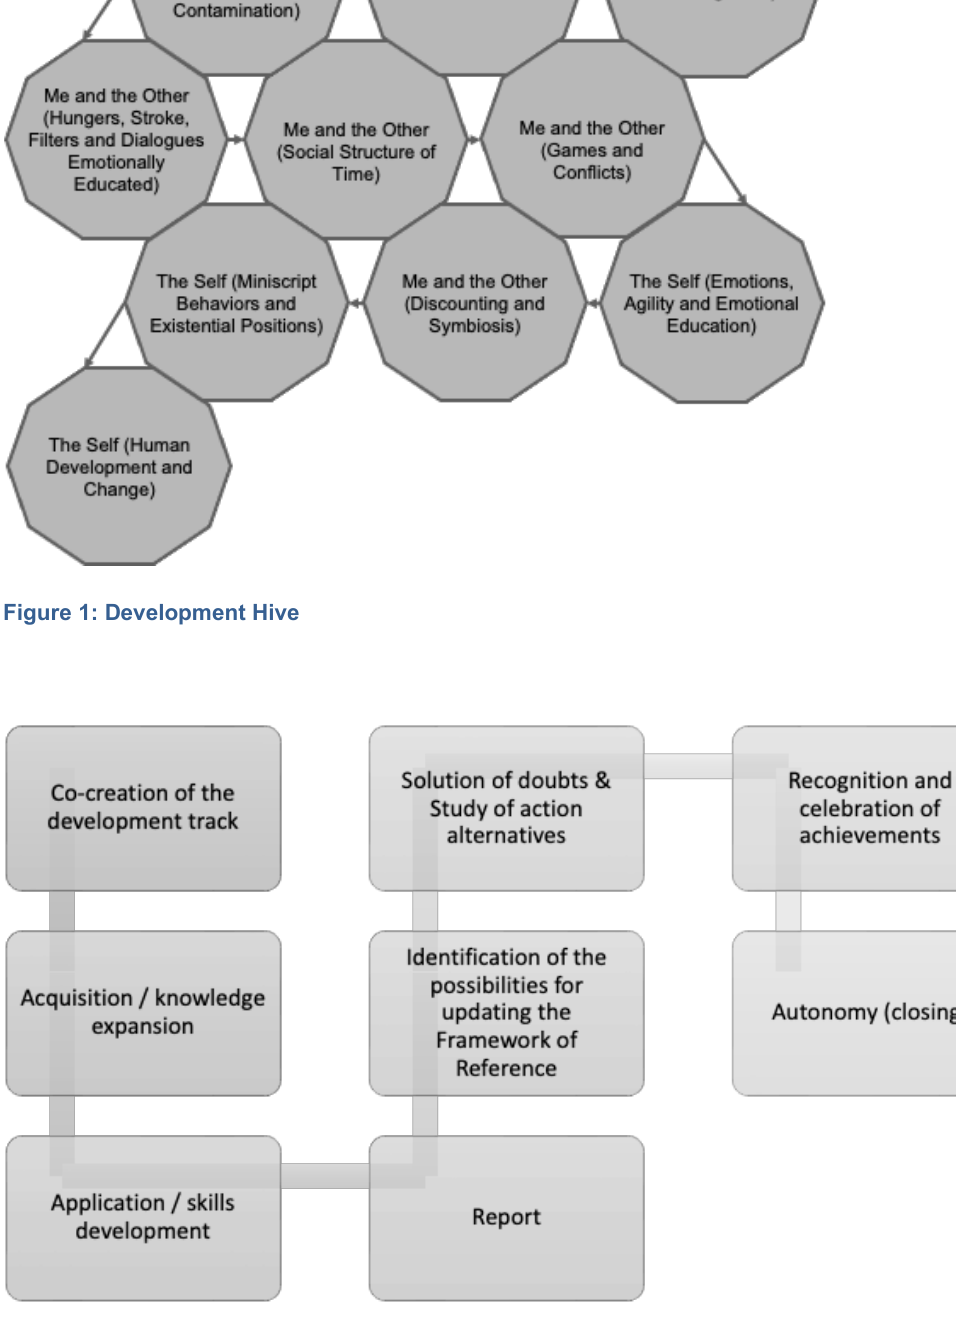
Figure 2: Relational Integrative Mentoring Process